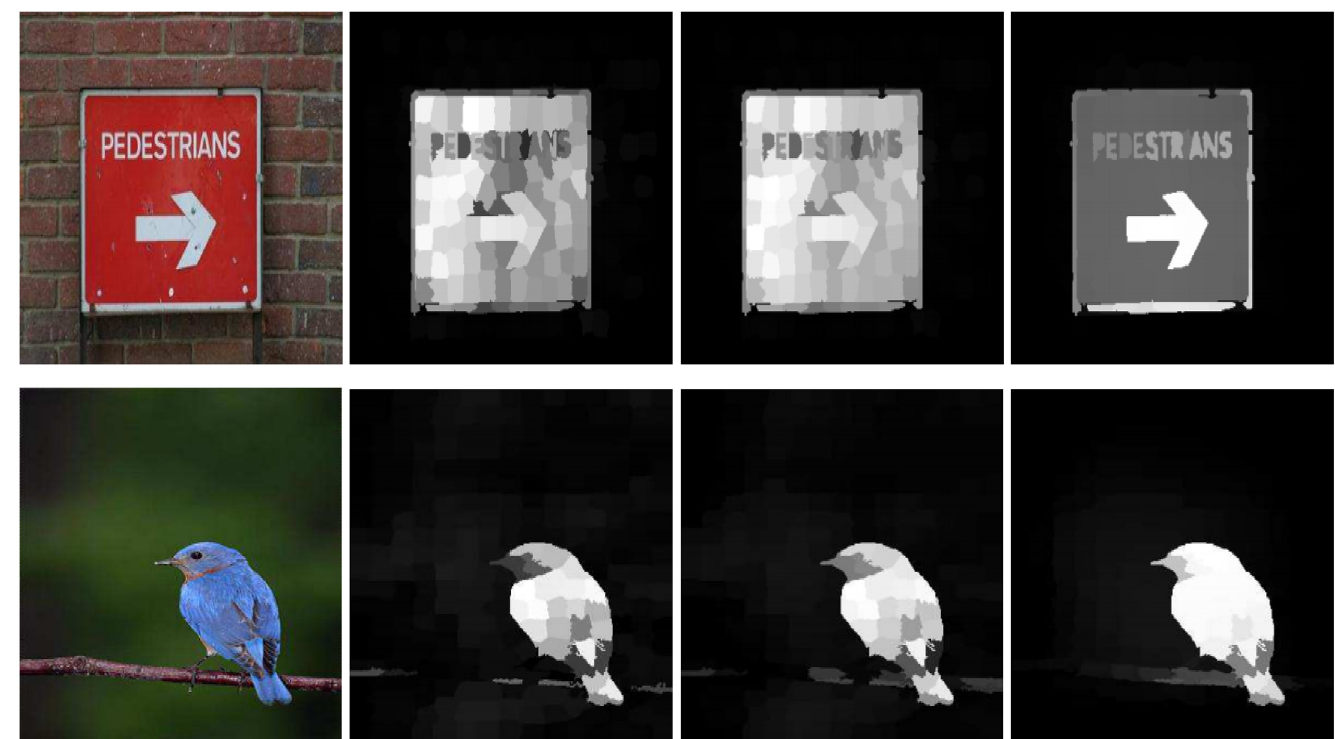
Fig 5. Comparison between different steps of our model and effectiveness of regularization terms. The results are arranged as: II, low-rank representation saliency map, our GRT map, and our MMRT map.